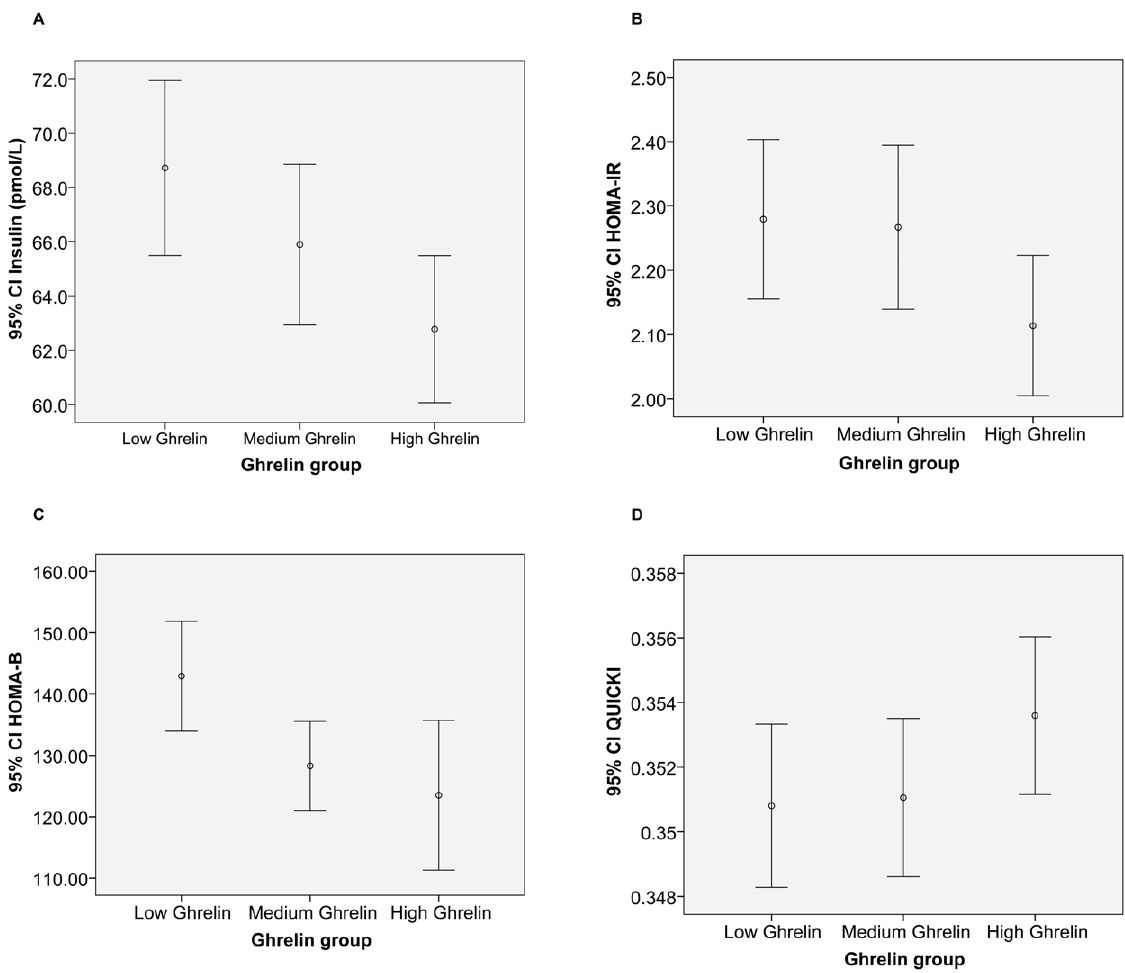
Figure 1. Error bars show the mean and 95% confidence interval for mean of insulin (A), HOMA-IR (B), HOMA- b (C) and QUICKI (D) in high, medium and low ghrelin groups.